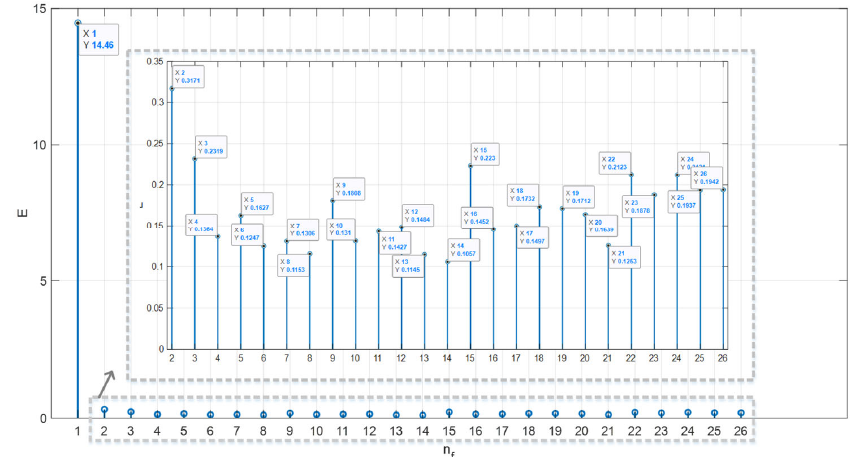
Figure 5. The cost function’s value as a function of the number of inputs.